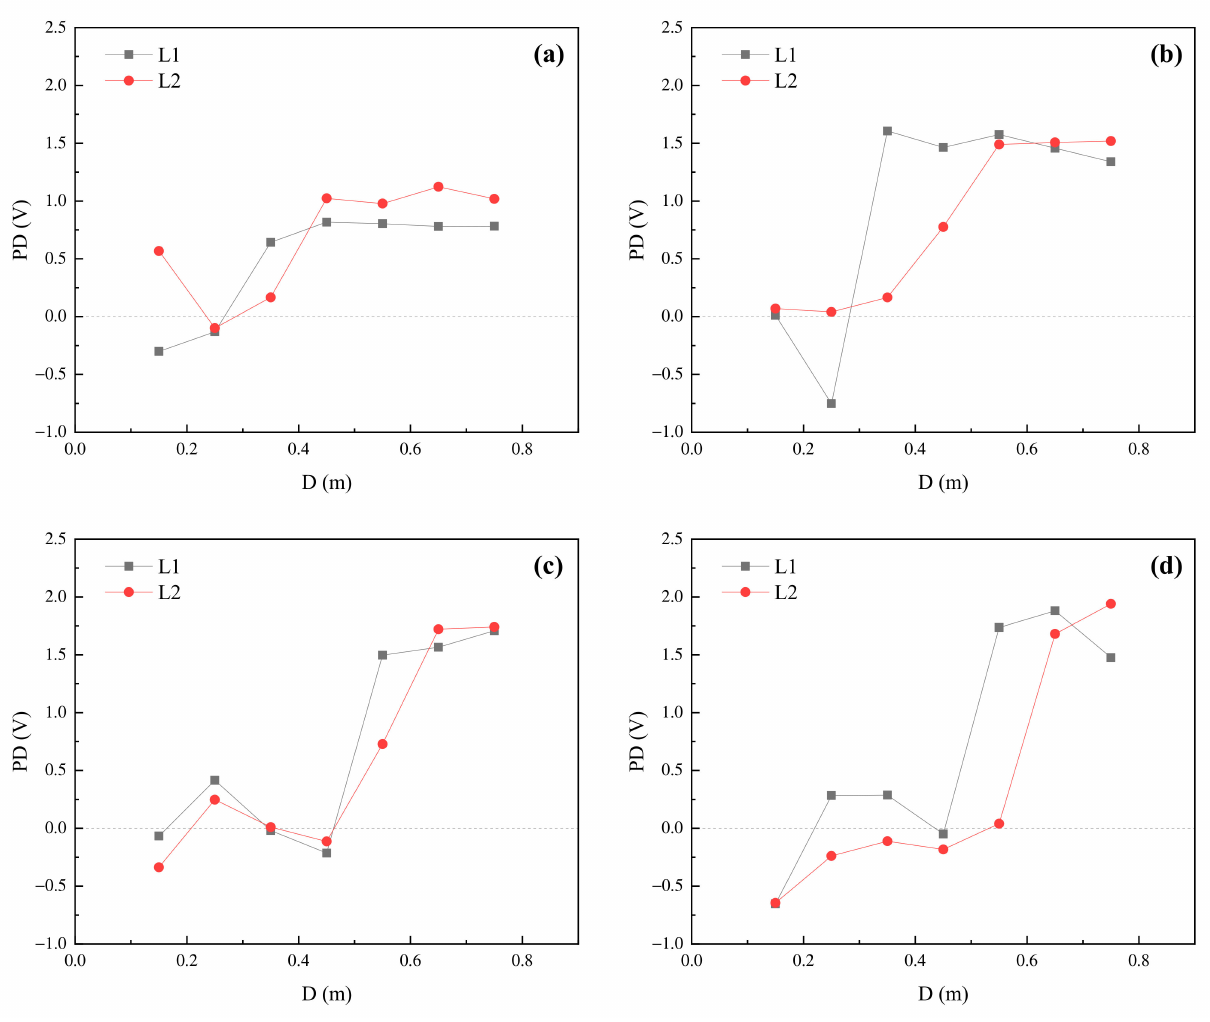
Figure 8. Distributions of PD for survey lines on the different dam models under the steady-state seepage. ( a ) DM 1; ( b ) DM 2; ( c ) DM 3; ( d ) DM 4; The D refers to the distance to dam crest along the downstream slope. The black square symbols and the red circle symbols represent the PD for LI and L2,